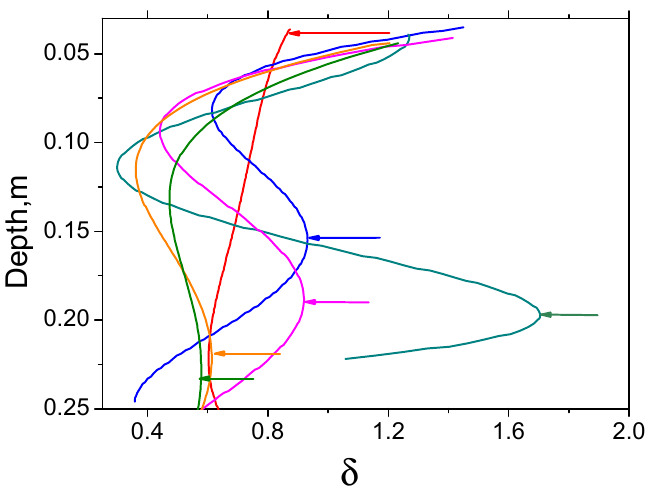
Figure 14. Polynomial functions approximating the derivatives of relative reflectivity δ (Equation (15)) for experiment 1 at different points in time from the beginning of drainage. The following colors